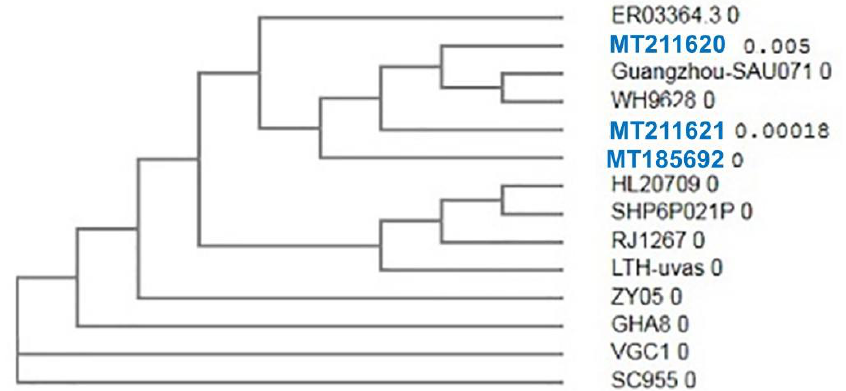
Figure 2. Dendrogram for nucleotide similarity between Staphylococcus aureus isolates from minced meat, Karish cheese, and human samples. Sequences (highlighted in blue color) from human samples (MT185692), minced meat (MT 211620), and Karish cheese (MT 211621) were generated in this study.